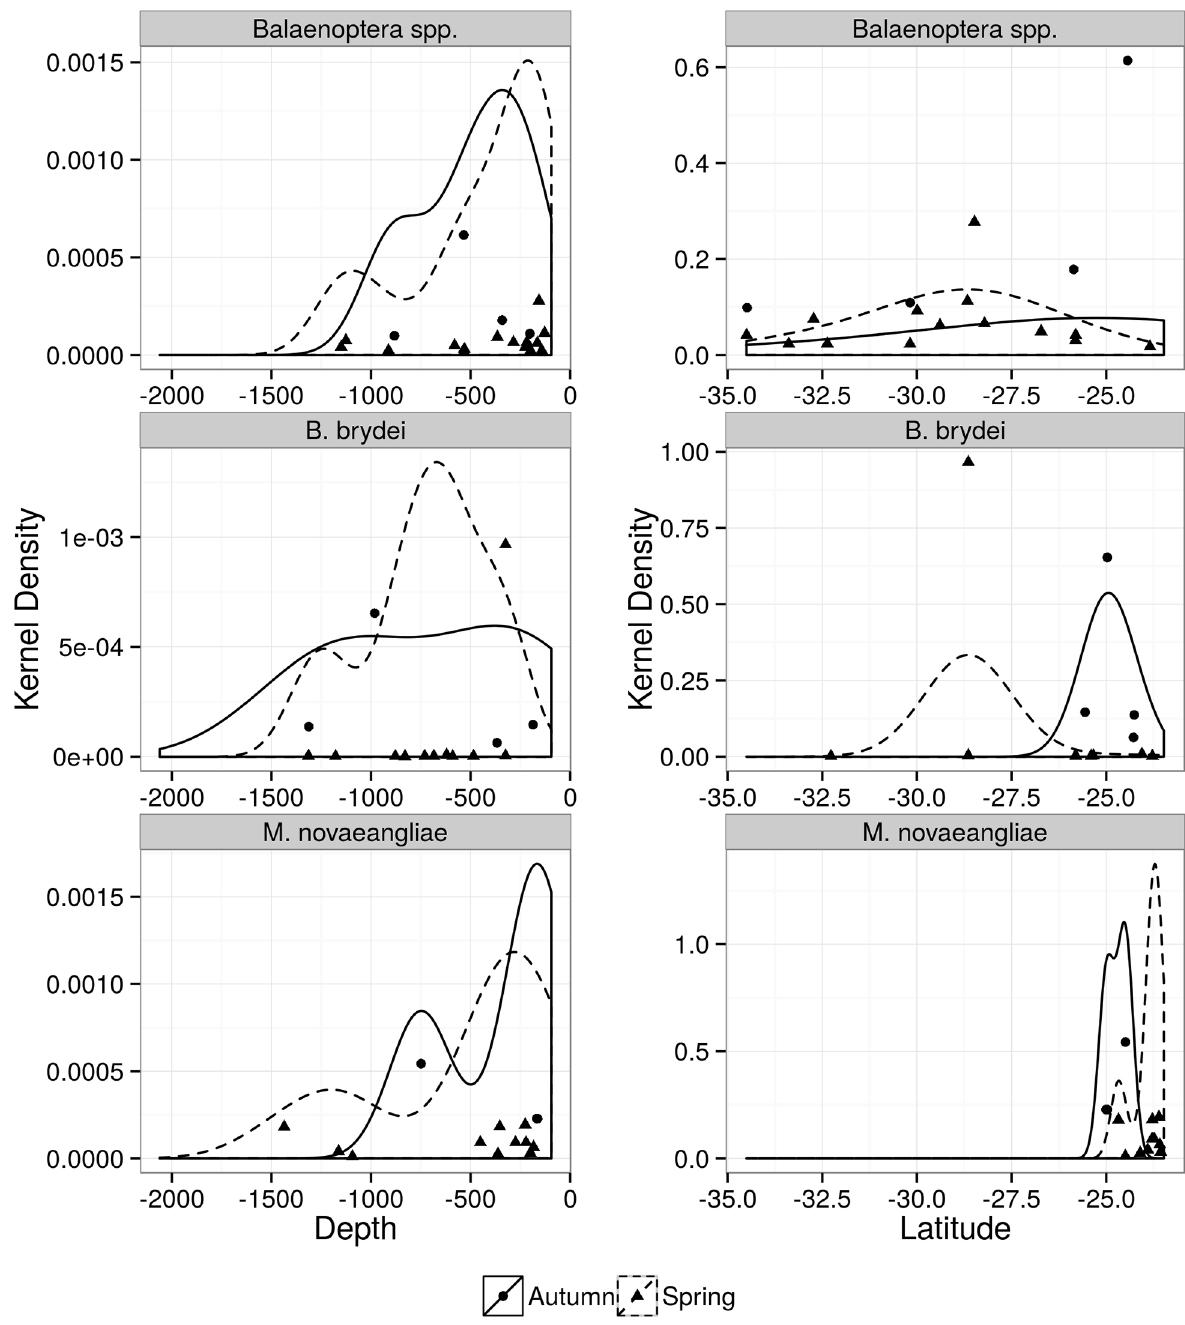
Fig 7. Kernel density distribution of unidentified minke whale ( Balaenoptera spp.), Bryde ’ s whale ( Balaenoptera brydei ), humpback whale ( Megaptera novaeangliae ). Plots are according to depth (left) and latitude (right) during spring (dashed lines) and autumn (solid black lines)